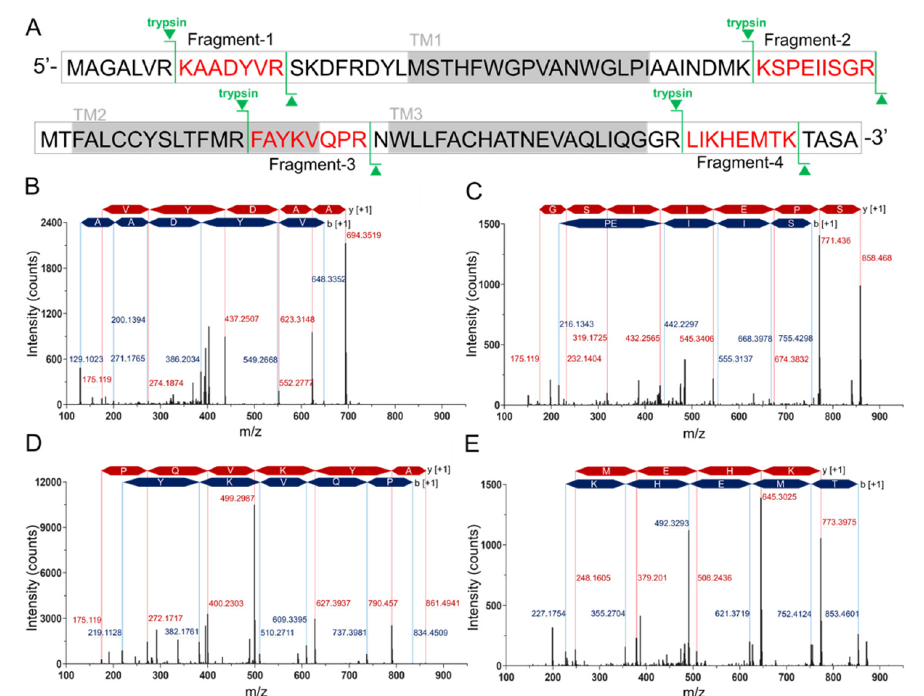
Figure 2. Tryptic peptide mapping of purified hMPC-1 by nano-LC-LTQ-Orbitrap-MS spectrum. ( A ) Sequence coverage of identified tryptic peptide fragments of hMPC-1. The peptide fragments identified in the LC-LTQ mass spectrum are highlighted in red. The trypsin digestion sites are marked in green lines. Gray boxes denote the transmembrane region. ( B–E ) The nano-LC-LTQ-Orbitrap-MS spectrum of tryptic peptide hMPC-1 fragments. The identified tryptic fragments sequence was as follows: ( B ) KAADYVR, ( C ) KSPEIISGR, ( D ) FAYKVQPR, and ( E ) LIKHEMTK. The peaks of the b-ion and y-ion are marked in blue and red together with identified amino acid sequences. The m / z of the identified peaks is labeled with blue and red characters.